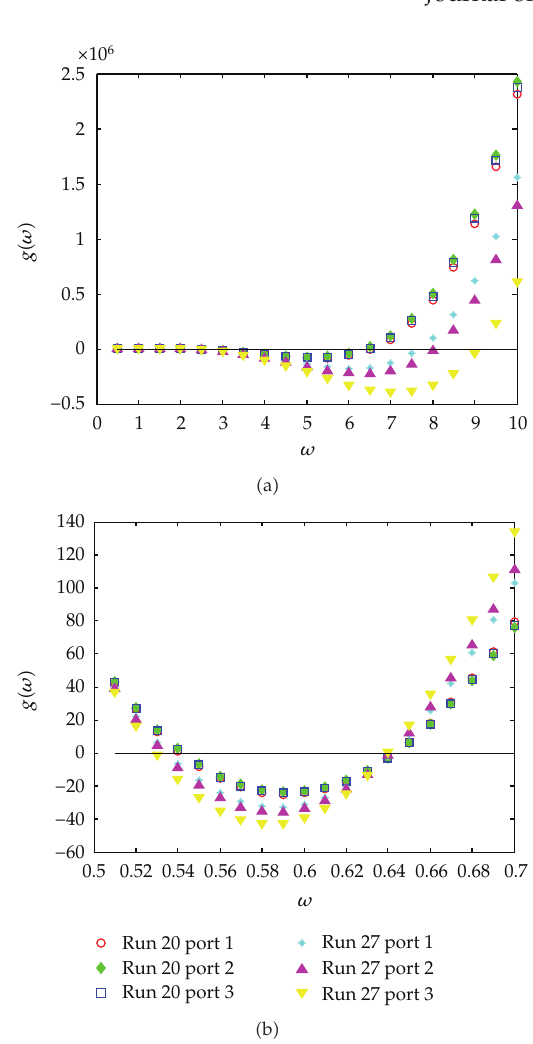
Figure 5: g (cid:2) w (cid:3) for Runs 20 and 27 over (cid:2) a (cid:3) a wide range of ω from 0 to 10 and (cid:2) b (cid:3) a narrow range of ω .